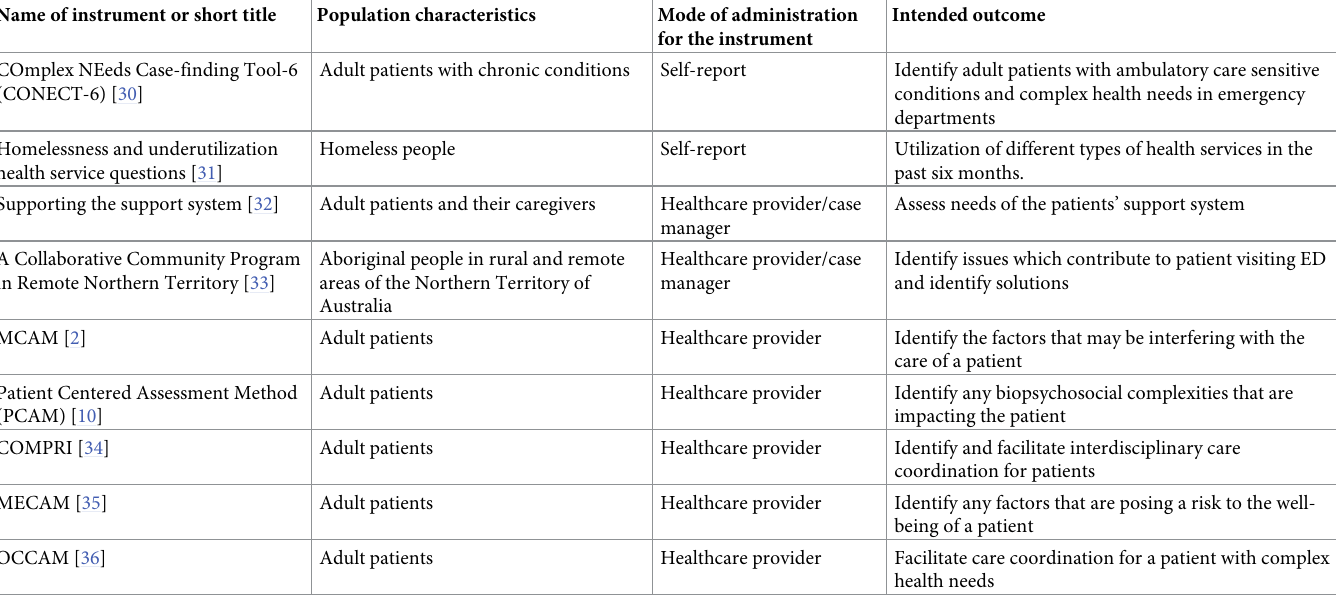
Table 1. Novel instruments identified by the scoping